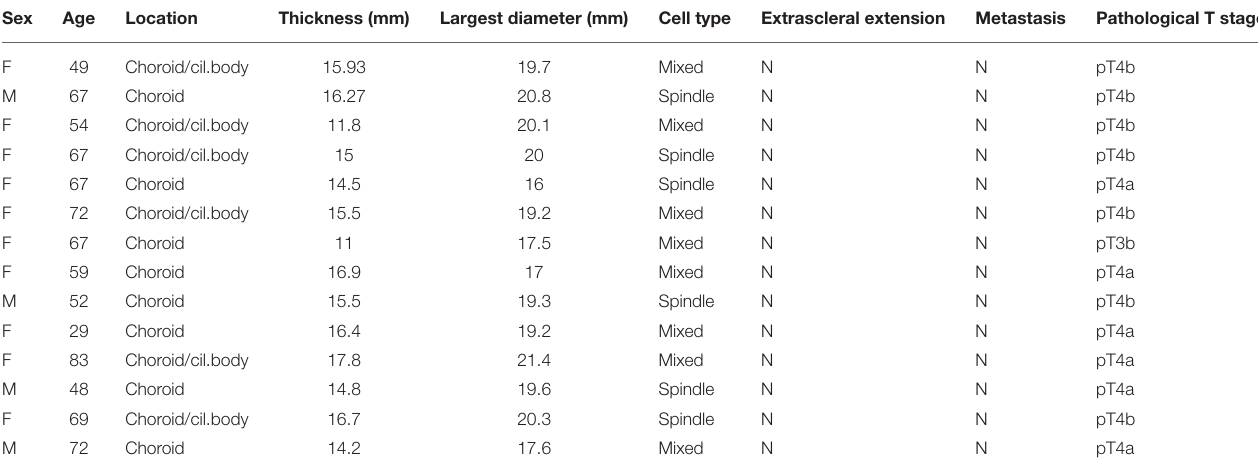
TABLE 1 | Demographics, tumor parameters, pathological stage in UM